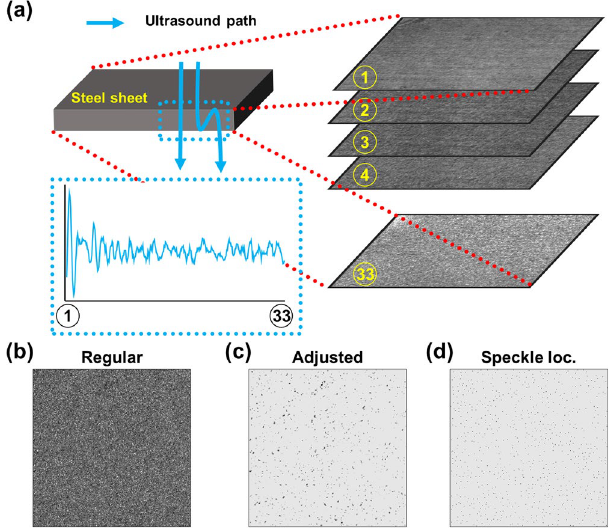
Figure 4. US signal processing procedure. ( a ) Acquisition of 3D volumetric data of the steel sheets and sampling of US C-scan images, ( b ) Acquired US C-scan image after envelope-processing and log-compression, ( c ) US C-scan image after adjusting the threshold, ( d ) US C-scan image after maximum localization of the speckles. (plotted by: MATLAB R2018a—https:// www. mathw orks. com/ produ cts/ matlab. html, Microsoft PowerPoint 2016—https:// www. micro soft. com/ en- us/ micro soft- 365/ power